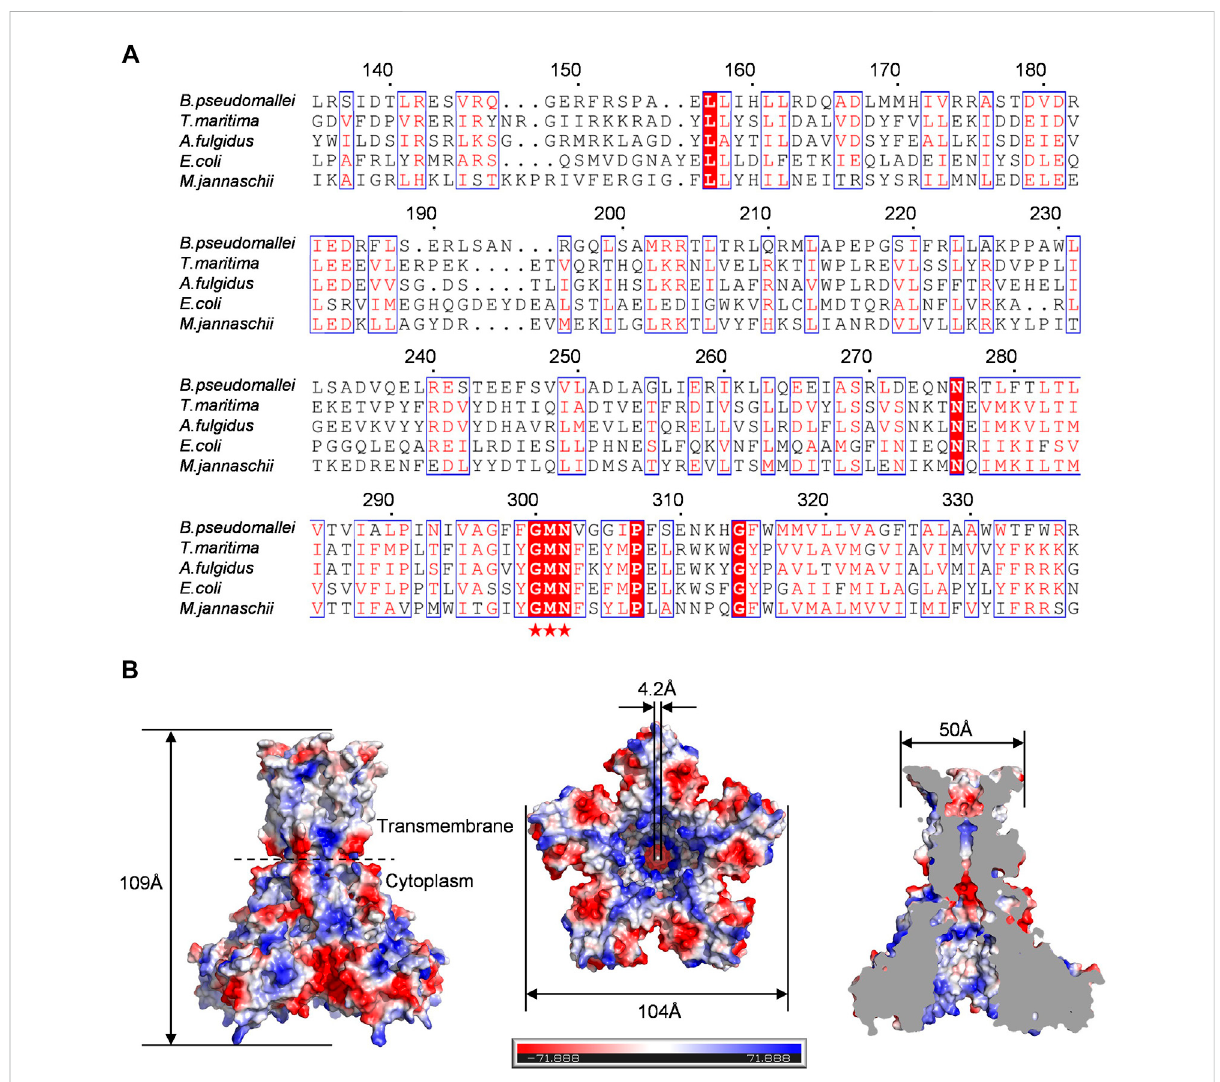
pentagram below. (B) The 3D structure of Bpss1228 was created by SWISS-MODEL (https://swissmodel.expasy.org/interactive) through homology modeling(PDB:7NH9astemplate).TheelectrostaticpotentialsurfaceoftheBpss1228predictionmodel,theheightofBpss1228isabout109 Å, the bottom of the cytoplasmic end is about 104 Å wide, and the extracellular end is about 50 Å wide, forming a channel with an internal diameter of about 4.2 Å at its narrowest